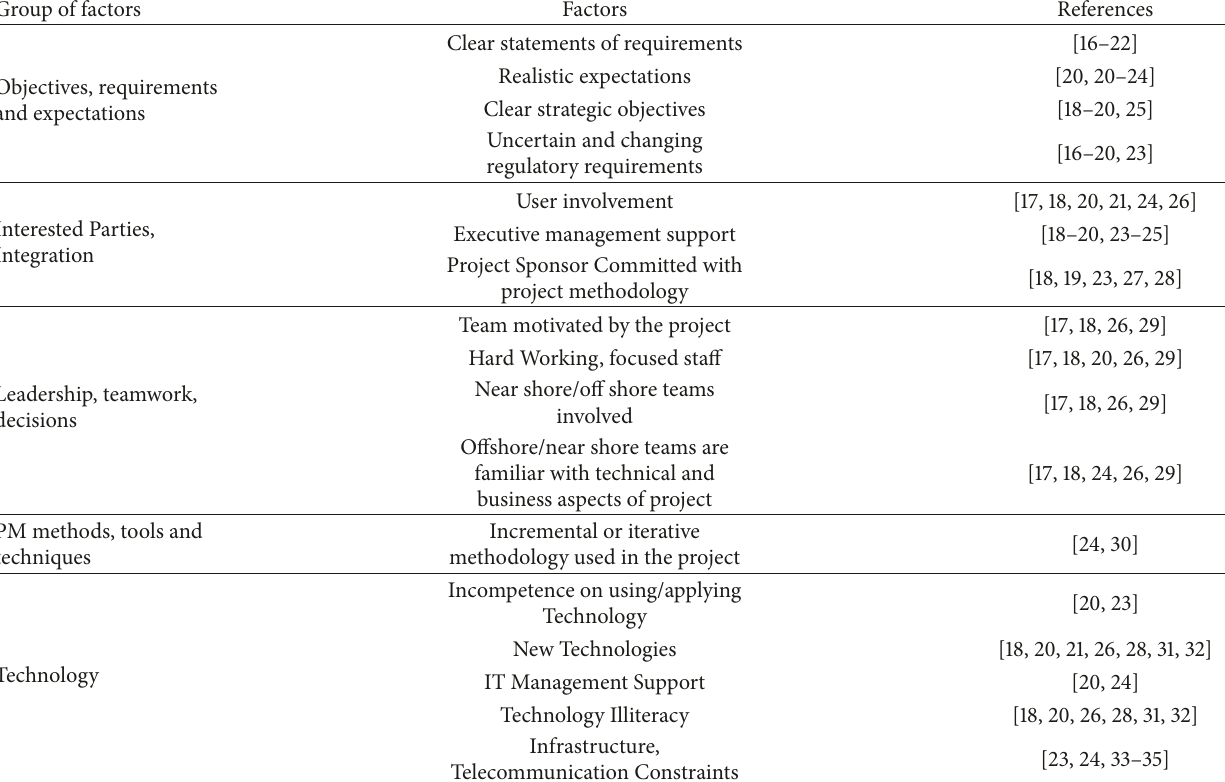
Table 2: IT Projects Complexity factors (literature